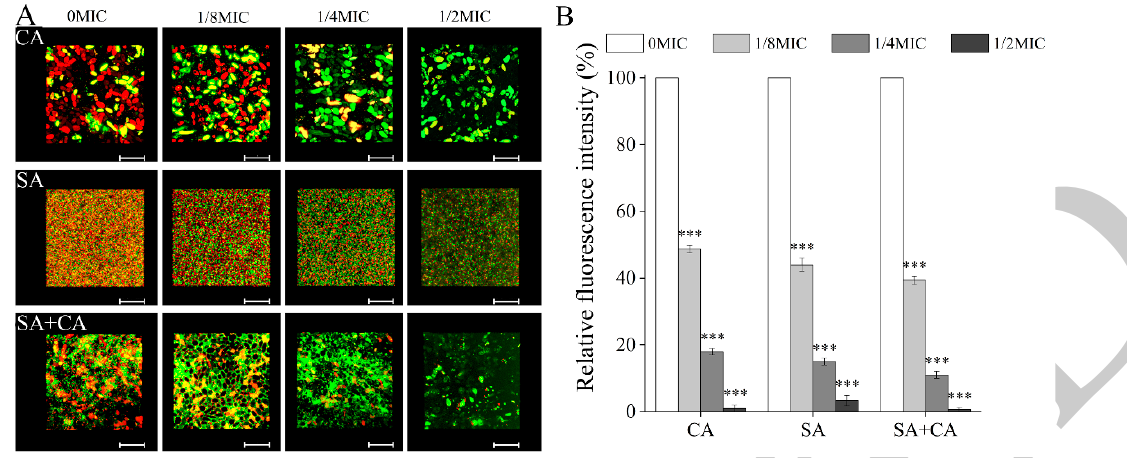
Figure 4. Effect of different concentrations of chelerythrine on C. albicans (CA) and S. aureus (SA) mono- and dual-species (SA+CA) biofilm matrix structure. (A) Extracellular proteins were stained with a red fluorescent stain SYPRO Ruby, and C. albicans and S. aureus cells were stained with a green-fluorescent nucleic acid counterstain STYO 9. Scale bars represent 10 μ m. (B) The relative fluorescence intensity of extracellular proteins in biofilms of each treatment group was plotted against that in untreated group by measuring red fluorescence intensities using KS 400 version 3.0 software. Bars represent the standard deviation ( n = 3). *** p < 0.001.